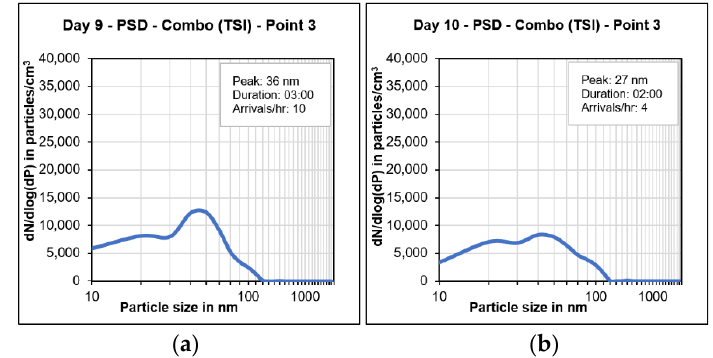
Figure 6. Particle size distributions on ( a ) day 9 and ( b ) day 10 (phase 2). In phase 3, the daily average PSD can be characterized by the peak particle size. Figure 7a–d shows the daily average PSD on days 11, 12, 13, and 14, respectively. On all days when the flight arrivals were measured, the highest particle concentration levels were in the lowest size class of 10 nm, which is the smallest particle size measured by the device. On day 12 (Figure 7b), there were rain prior to the measurements and the particle concentration was relatively low compared to that of the day before. However, the general shape of the size distribution remained the same with the highest number of particles being in the 10 nm size class. A similar trend for the PSD was seen on days 13 and 14, as shown in Figure 7c,d, respectively. However, the number of particles per cm 3 was higher for the 10 nm size class on these days.